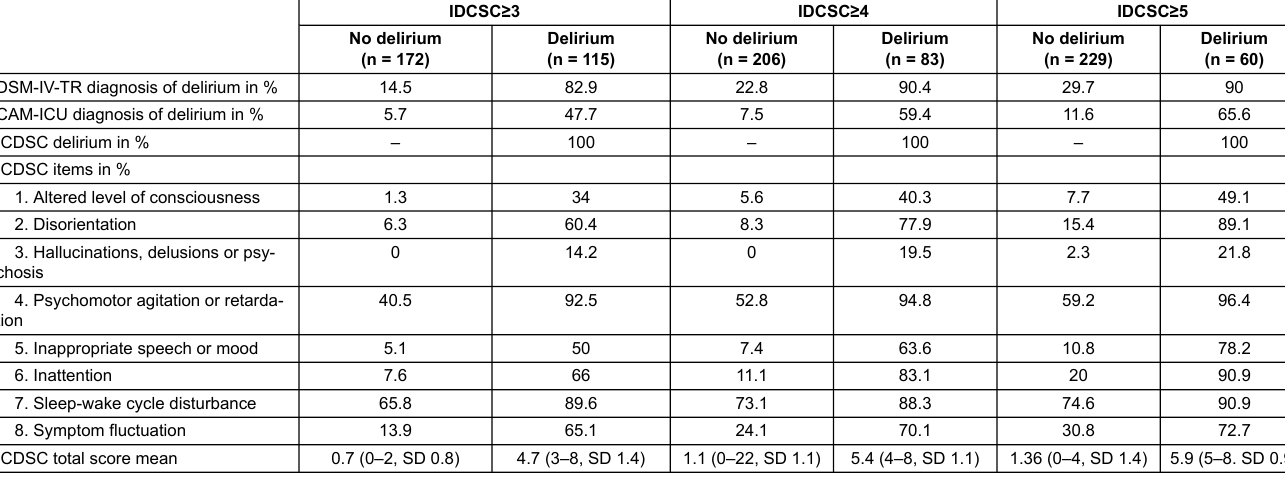
Table 3: Characterisation of the absence and presence of delirium as determined by varying the ICDSC threshold from ≥3 to ≥5.